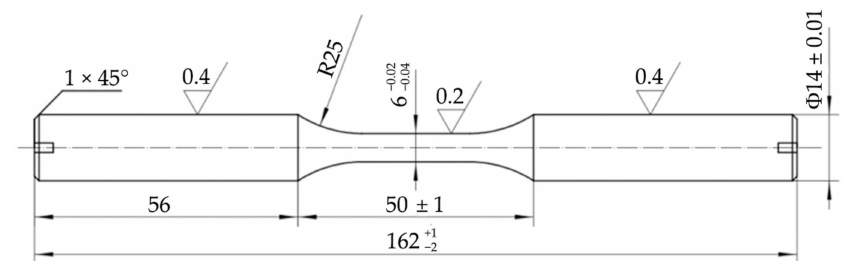
Figure 2. The geometry and dimensions of the smooth hourglass-type